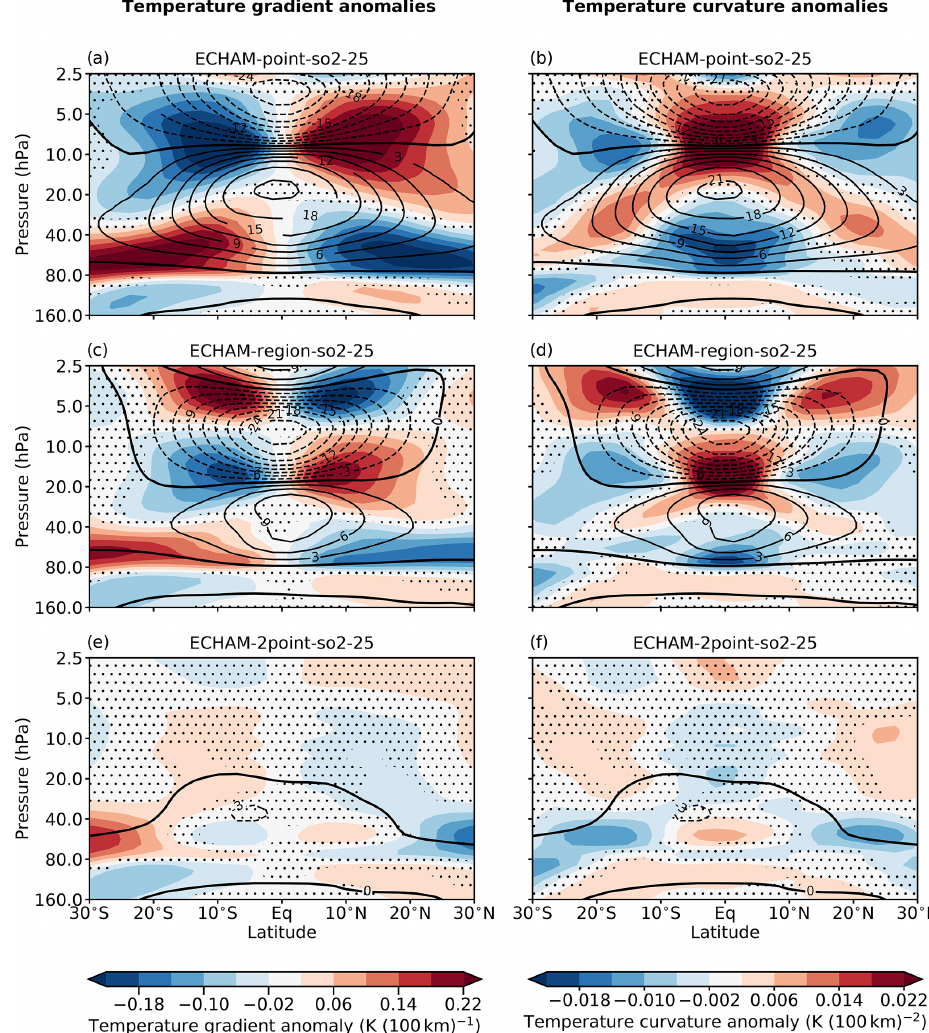
Figure 5. Latitude–height cross section of the anomaly of the meridional zonal mean temperature gradient T y (a, c, e) and of the anomaly of the meridional zonal mean temperature curvature T yy (b, d, f) for the ECHAM simulations of point-so2-25 (a, b) , region-so2-25 (c, d) , and 2point-so2-25 (e, f) . Stippling indicates areas where anomalies are not significant at the 95% level in Student’s t test. Black contour lines indicate the anomaly of the zonal mean zonal wind speed u in intervals of 3ms − 1 , with the thick black line denoting u = 0ms − 1 . Solid lines denote a westerly anomaly; dashed lines denote an easterly